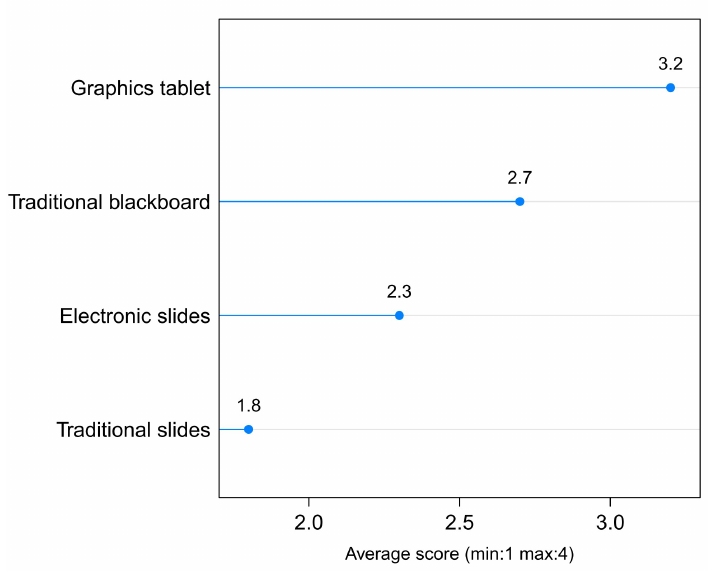
Figure 6. Queston 5: teaching tools preference. Graphics tablet is the most appreciated tool, followed by the traditonal